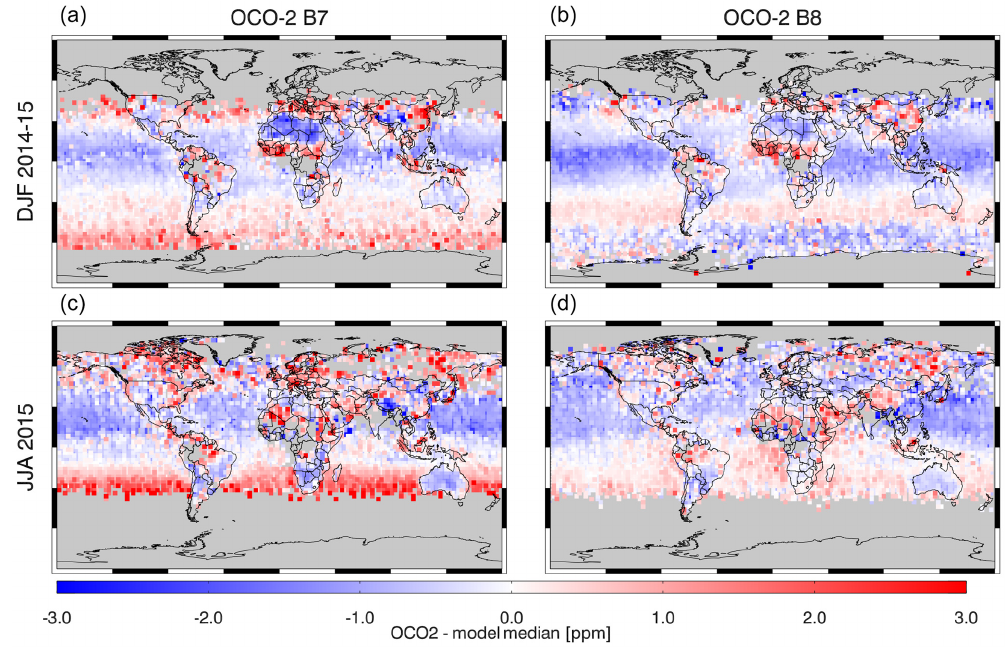
Figure 19. The difference between OCO-2 bias-corrected X CO and version 8 (b, d) , using the agreement criteria as given in Sect. 4.1.3. Results are shown for two seasons: DJF 2014–2015 (a, b) and JJA 2015 (c, d)